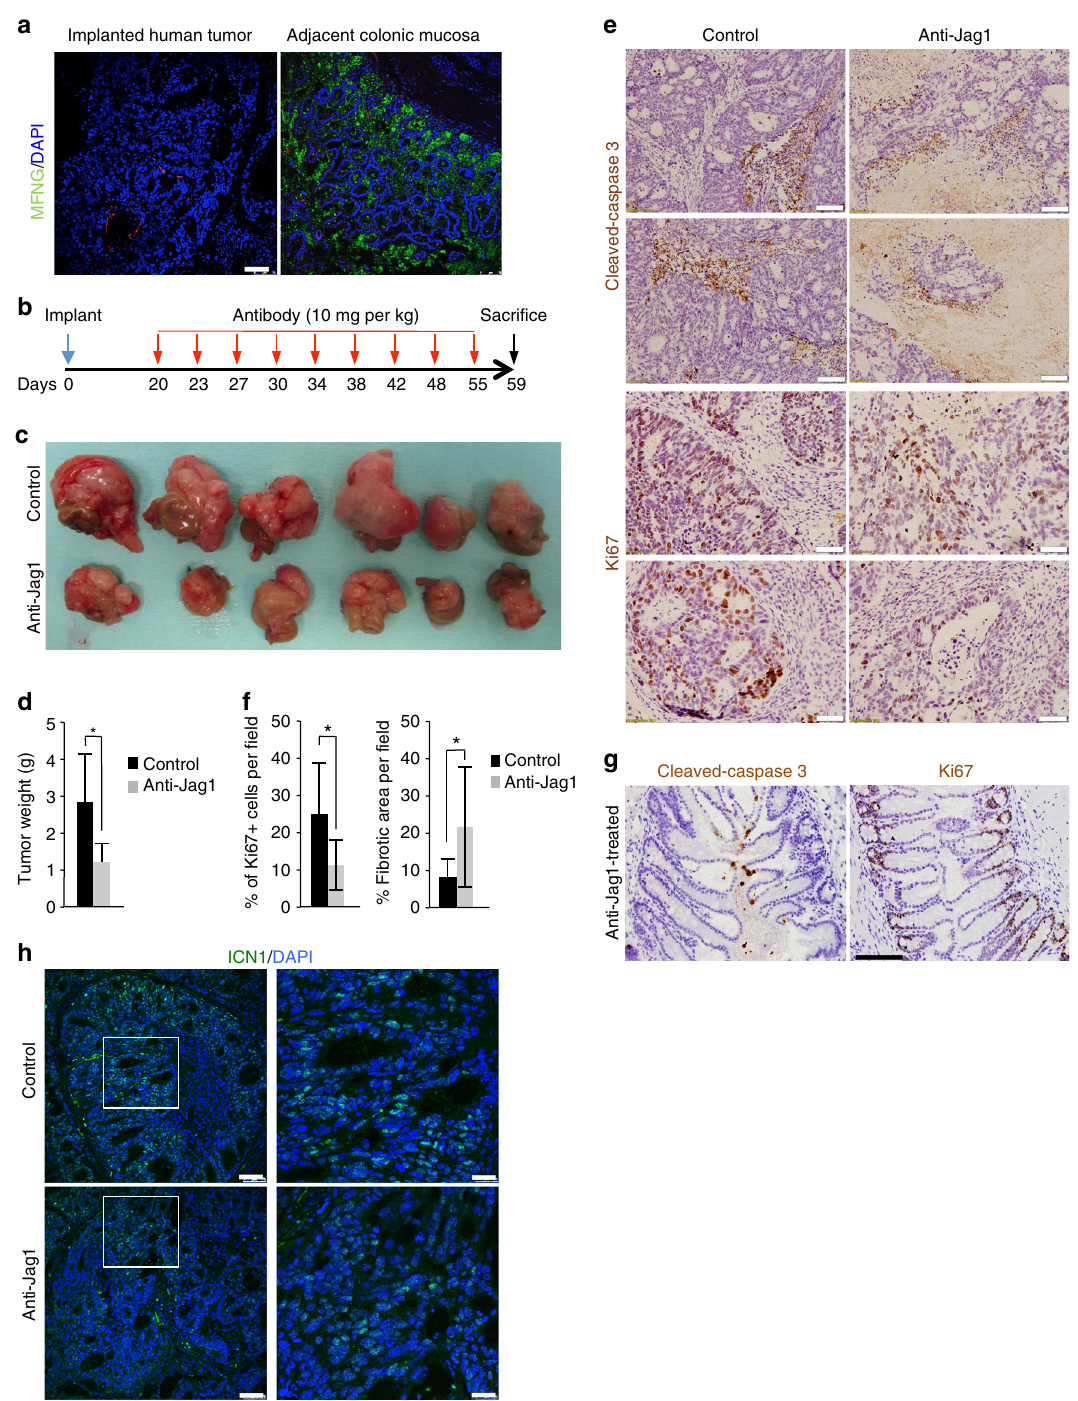
Fig. 6 Treatment with antibody against Jag1 decreases human CRC tumor growth in vivo. a IF analysis of MFNG expression in the transplanted human tumor and the adjacent normal colonic mucosa. b Scheme of the protocol used for testing the anti-tumor activity of anti-Jag1 antibody in vivo (10 mg per kg). c Photograph of the tumors recovered at the end of the experiment with the indicated treatments. d Median and standard deviation of tumor weight in the animals from both groups of treatment. e Representative images of IHC analysis of cleaved-caspase 3 and the proliferation marker Ki67 in two representative tumor sections from control and anti-jag1-treated animals and f average values and standard deviation of the data obtained from eight independent 20× fi elds analyzed using the ImageJ program. Statistical signi fi cance of the differences between control and anti-Jag1-treated groups was determined by t -test comparing. g IHC analysis with the indicated antibodies in normal adjacent tissue. h IF analysis of active Notch1 (ICN1) in representative control and anti-Jag1-treated tumors. Scale bars represent 75 μ m in ( a ), 100 μ m (cleaved-caspase 3) and 50 μ m (Ki67) in ( e ), 200 μ m in ( g ), and 75 μ m and 25 μ m (magni fi cation) in ( h